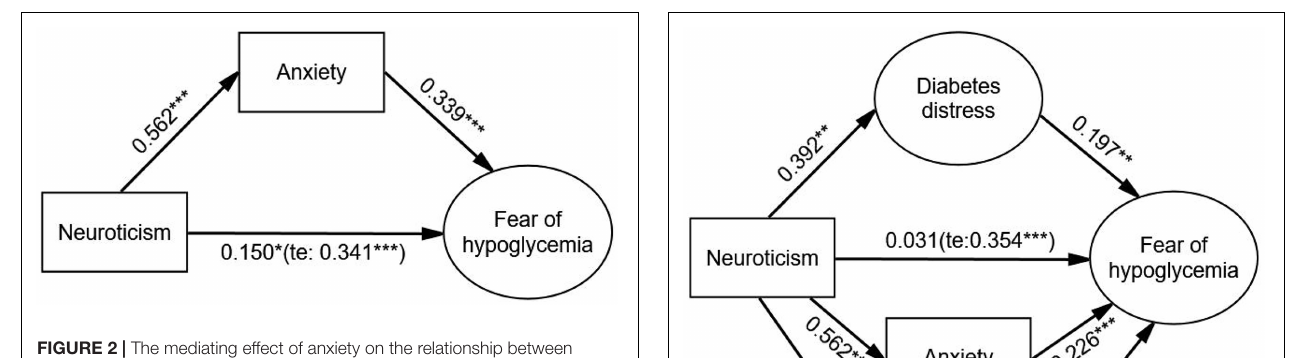
FIGURE 2 | The mediating effect of anxiety on the relationship between neuroticism and FoH. Standardized estimating of 5,000 bootstrap sample. Age, sex, duration of diabetes, duration of insulin use, hypoglycemic episodes in the past year, and living alone were controlled. te, total effect. Significant codes: *** p < 0.001, * p < 0.05.